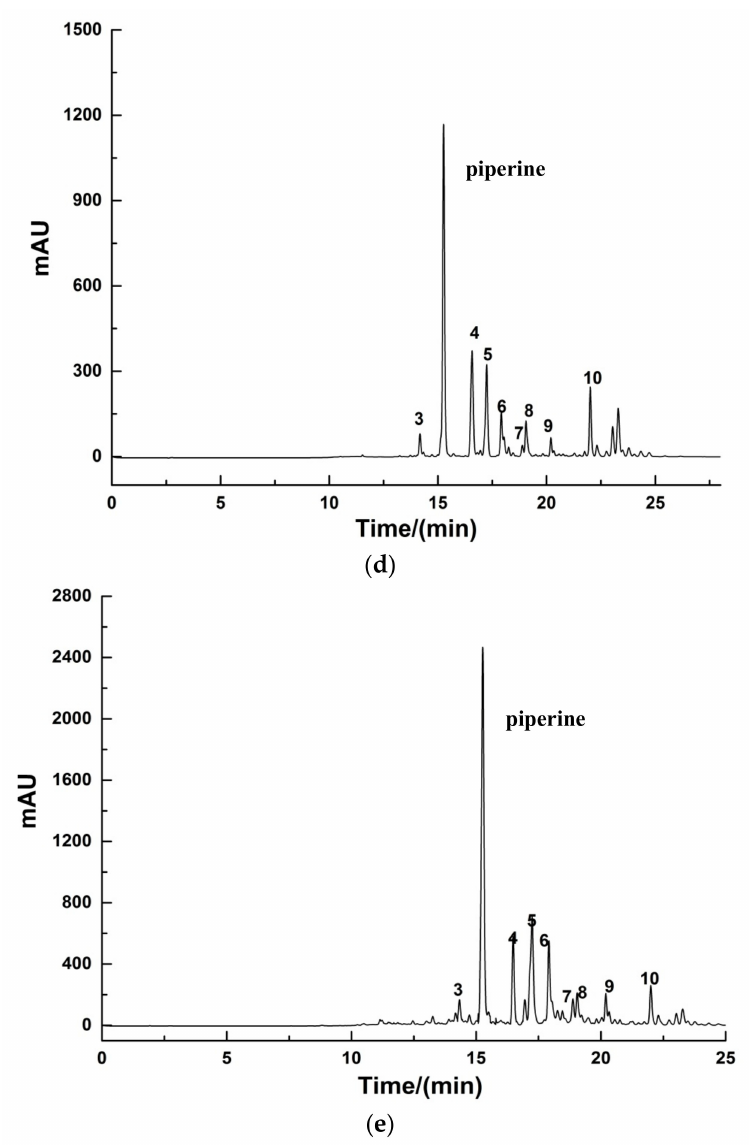
Figure 4. HPLC profiles of pepper phenolic crude extracts of S0 ( a ) and C3 pepper phenolic fractional extracts: ( b ) aqueous extracts; ( c ) n -butanol; ( d ) ethyl acetate; ( e ) petroleum